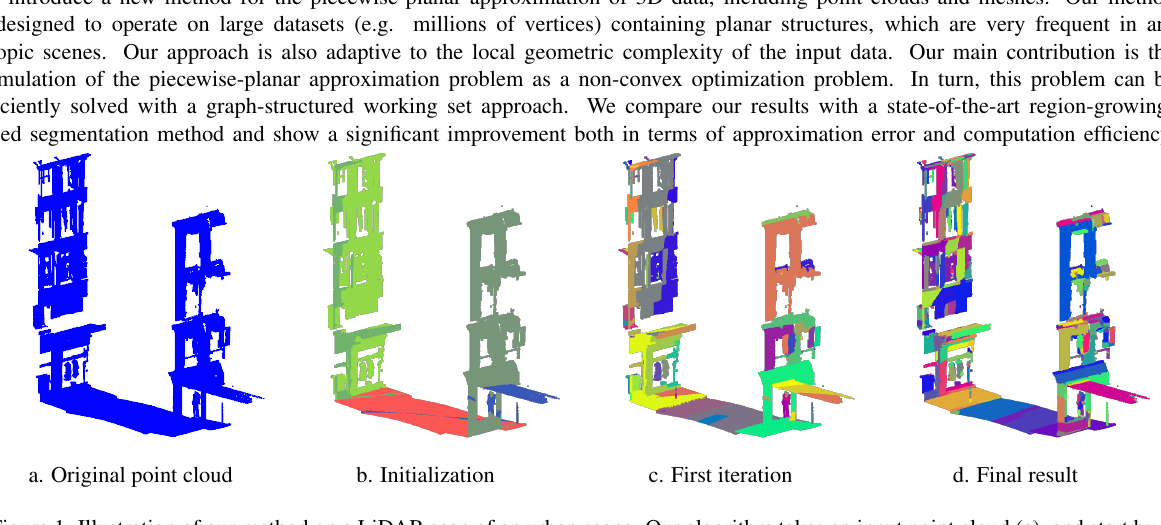
Figure 1. Illustration of our method on a LiDAR scan of an urban scene. Our algorithm takes an input point cloud (a), and start by extracting planes using a RANSAC approach (b). These planes are used to initialize a graph-structured working-set algorithm. We represent the evolution of the approximation, after the first (c) and the last (d) iteration. Each color represents a different